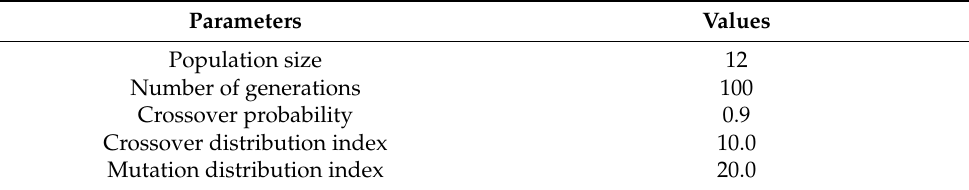
Table 2. Parameters setting of NSGA-II.